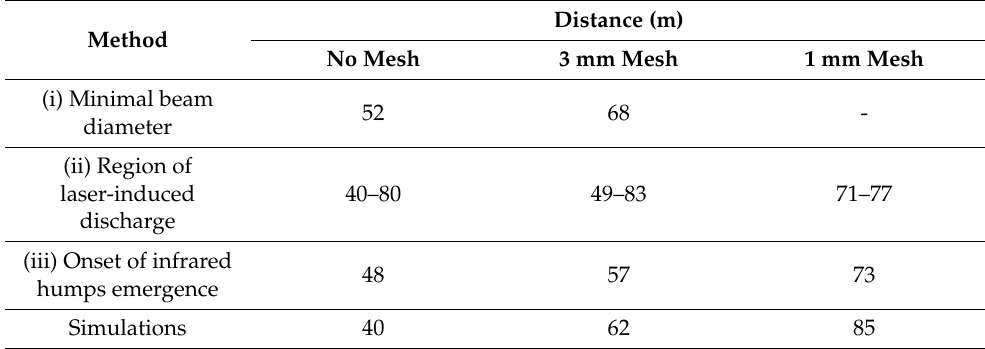
Table 1. The location of the high-intensity zone along the propagation path obtained by different